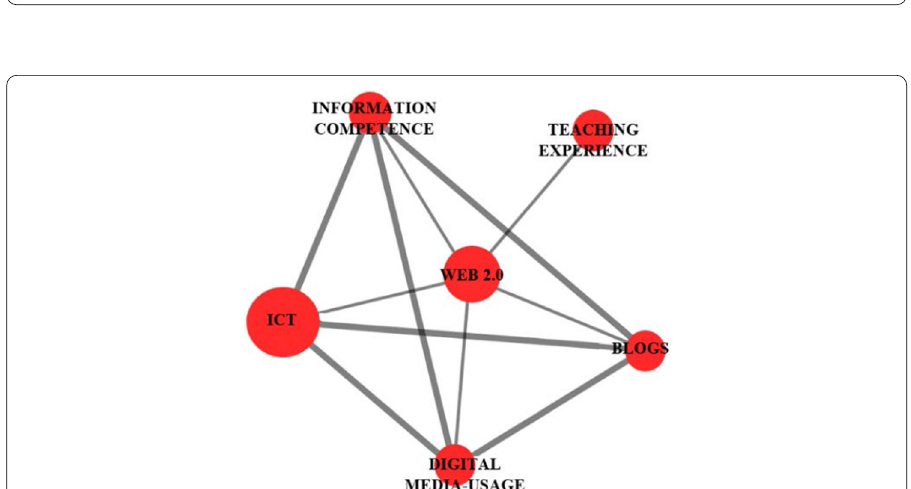
Fig. 5 Emerging and declining thematic networks in university